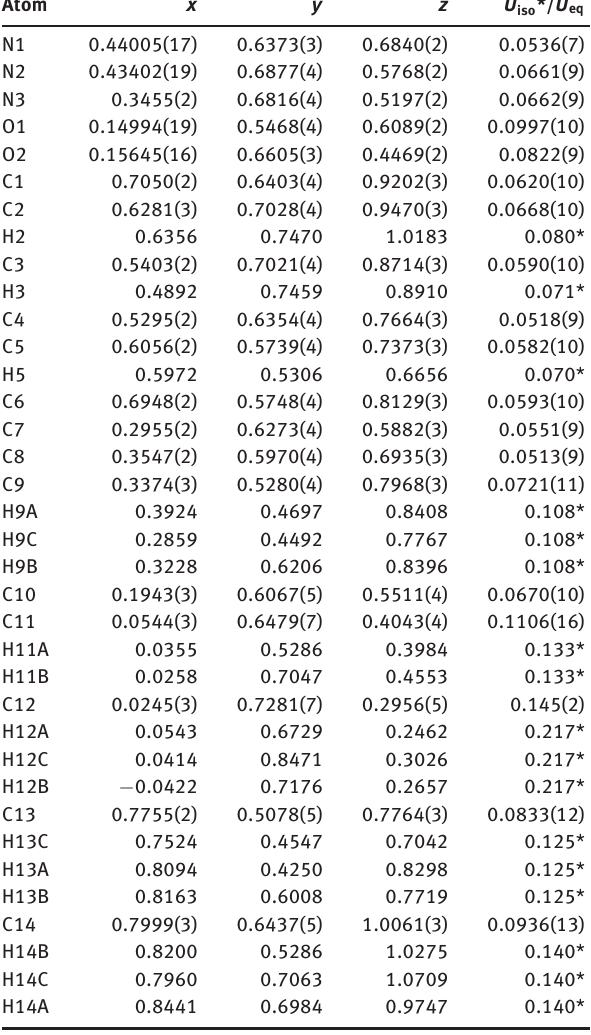
Table 2: Fractional atomic coordinates and isotropic or equivalent isotropic displacement parameters (Å 2